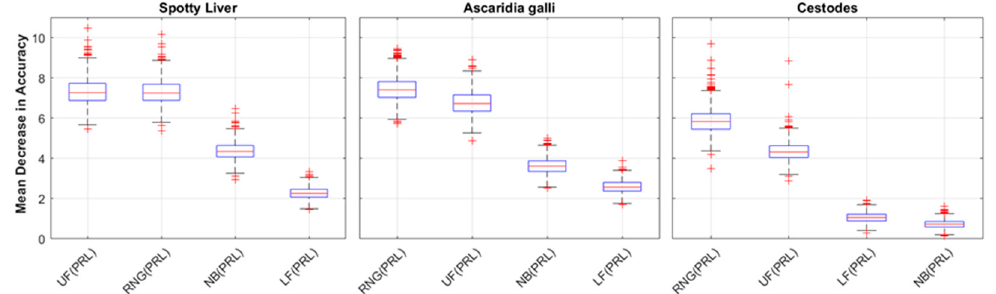
Figure 8. Feature importance measure through the mean decrease in accuracy for the three responses with the highest AUC values—( left ) Spotty Liver, ( middle ) Ascaridia galli , and ( right ) Cestode infestation. The responses have been classified according to the location of the hen on either the range (RNG), upper feeder (UF), lower feeder (LF), or nest box (NB) during pre-lay (PRL), peak lay (PL), late lay (LL), or end of lay (EL).